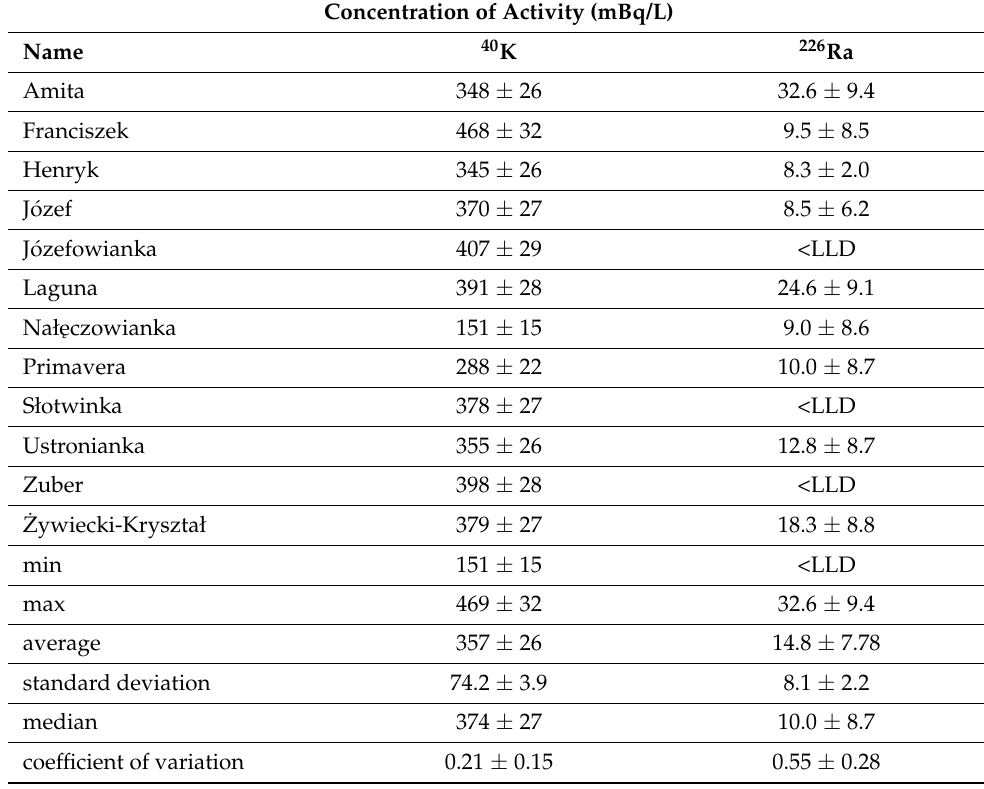
Table 1. Values of the concentration of potassium 40 K and radium 226 Ra activity together with the results of statistical